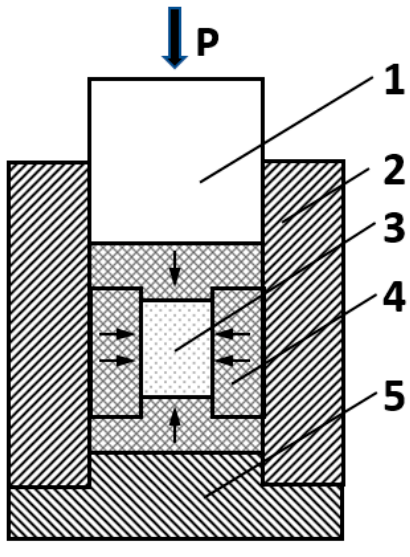
Figure 3. A schematic drawing of a cylindrical press for quasi-isostatic pressing: 1—punch; 2—matrix; 3—powder with a shape of a cylinder; 4—elastomer; 5—base.